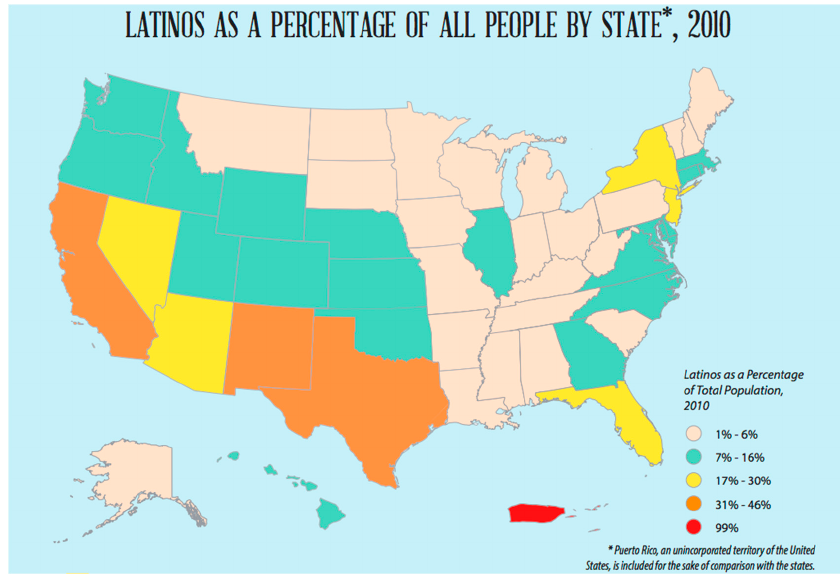
Societies 2020 , 10 , x FOR PEER REVIEW Figure 1. Latinx population in the United States. Source: Authors. Figure 1. Latinx population in the United States. Source: Authors.